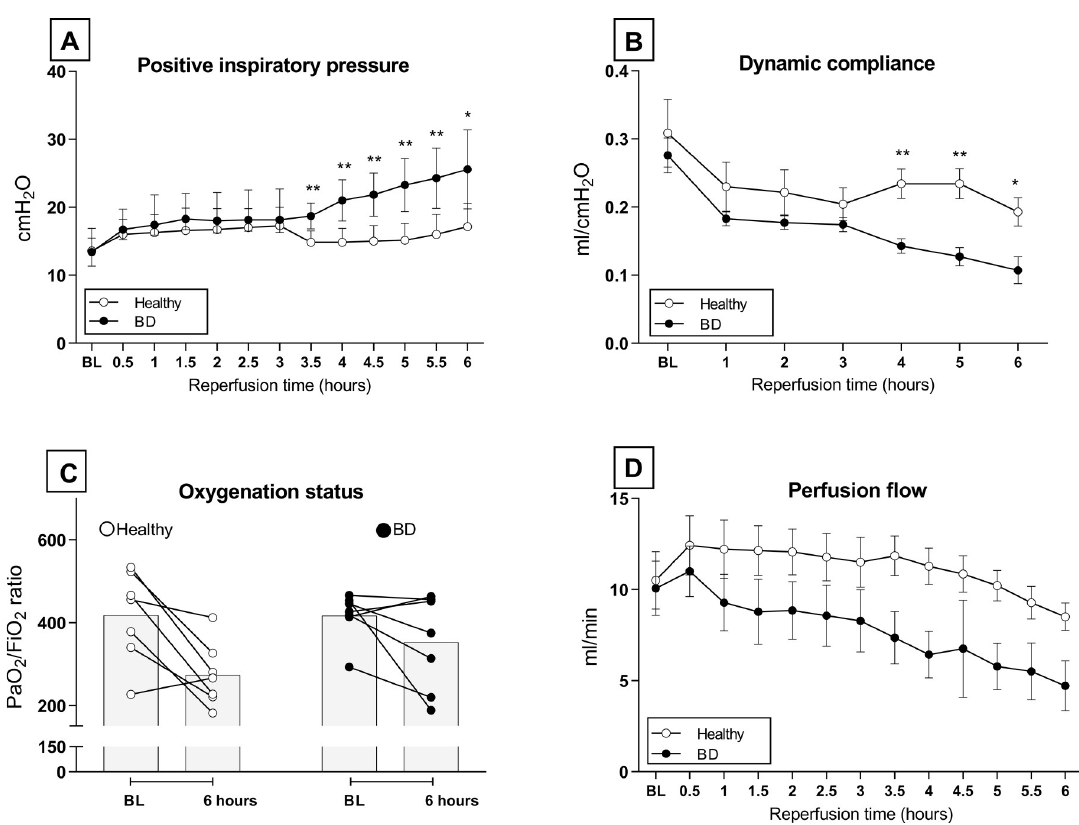
Fig 6. Ventilation and perfusion performance during ex vivo lung perfusion. Lungs from healthy donor rats or rats subjected to 3 hours of brain death (BD) and 1 hour cold storage (CS) were ex vivo perfused for 6 hours (EVLP, experimental group 3 and 4). (A) Positive Inspiratory Pressure (PIP) required to maintain tidal volume at 7 ml/kg of bodyweight over time, during EVLP. (B) Dynamic compliance (C dyn ) of donor lungs over time, during EVLP. (C) Oxygenation capacity of donor lungs as reflected by PaO 2 /FiO 2 ratio. (D) Perfusion flow of donor lungs over time, during EVLP. � p < 0.05 in healthy donor lungs versus lungs from brain-dead donors subjected to EVLP. �� p < 0.01 in healthy donor lungs versus lungs from brain-dead donors subjected to EVLP.